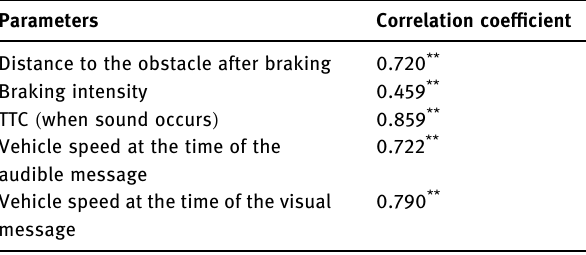
Table 13: Correlation of TTC ( when visualisation occurs ) with the rest of the parameters Parameters Correlation coe ffi cient Distance to the obstacle after braking